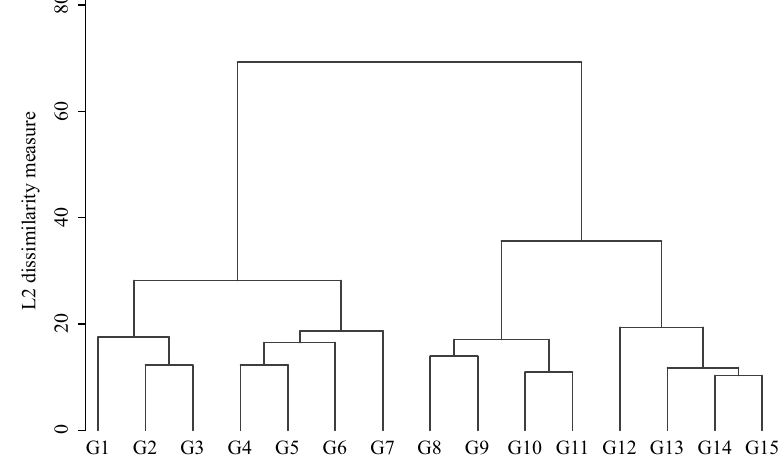
Fig. 1. Dendrogram of cluster analysis, limited to top 15